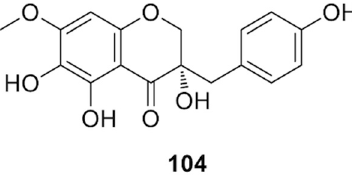
Figure 16. Chemical structure of compound 104 isolated from D. usambarensis.